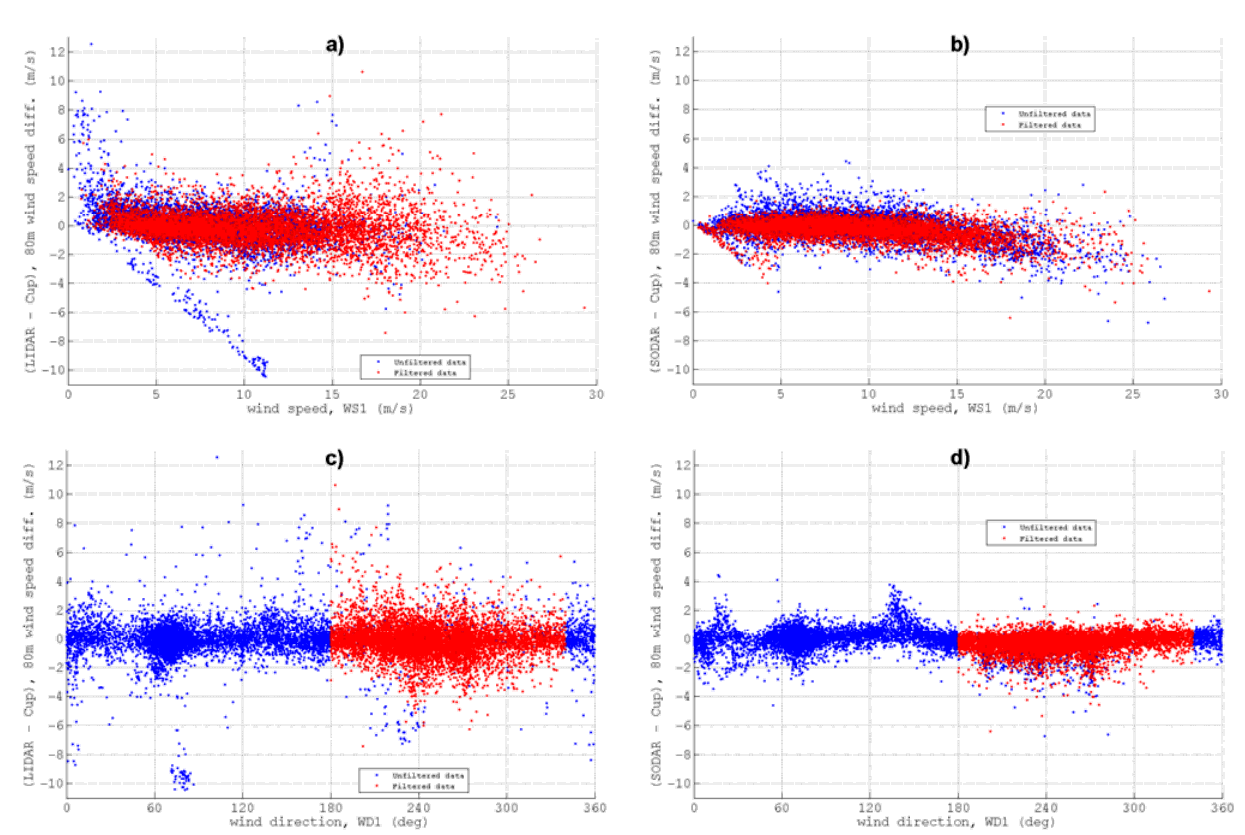
Figure 7. LIDAR-Cup (a,c) and SODAR-Cup (b,d) wind speed differences, as a function of wind speed (a,b) and direction (c,d) ; Filtered by direction and data quality parameter only. (February–May; 10 min